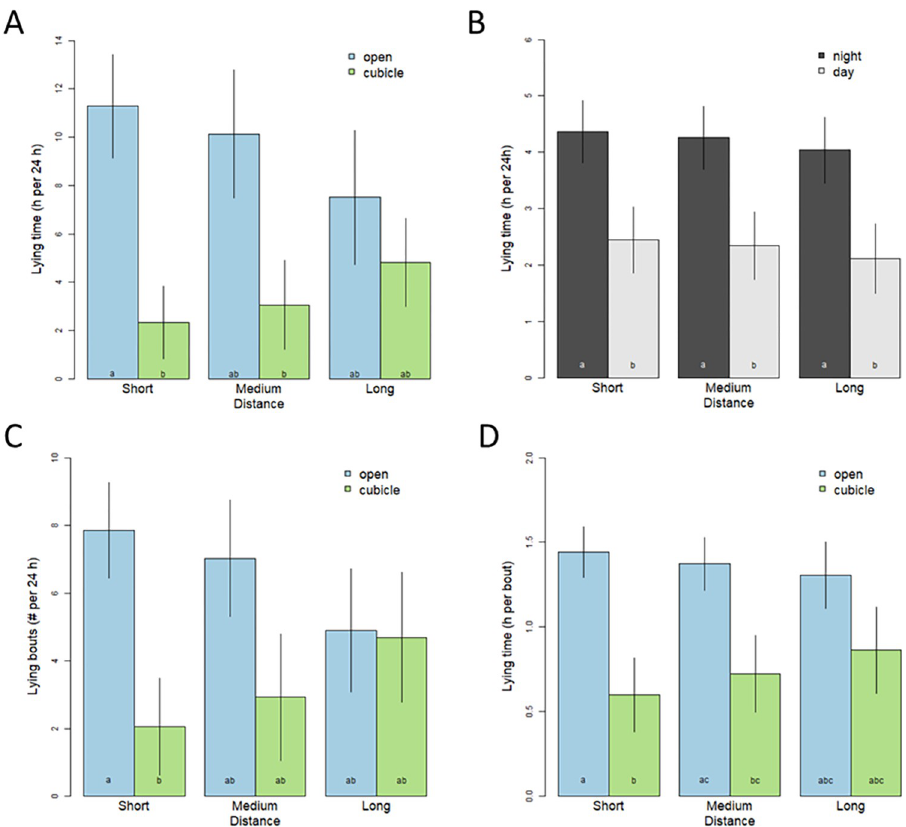
Fig 3. Lying as a function of distance choice treatment. Bar height represents the category mean and error bars represent the category 95% confidence interval (based on cow groups). Letters represent mean differences based on post hoc pairwise tests (Sidak corrected alpha = 0.05). A. Lying time per 24 h in open lying areas versus cubicles. B. Lying time per 24 h at night versus daytime. C. Frequency of lying bouts per 24 h in open lying areas versus cubicles. D. Average duration of lying bout per 24 h in open lying areas versus